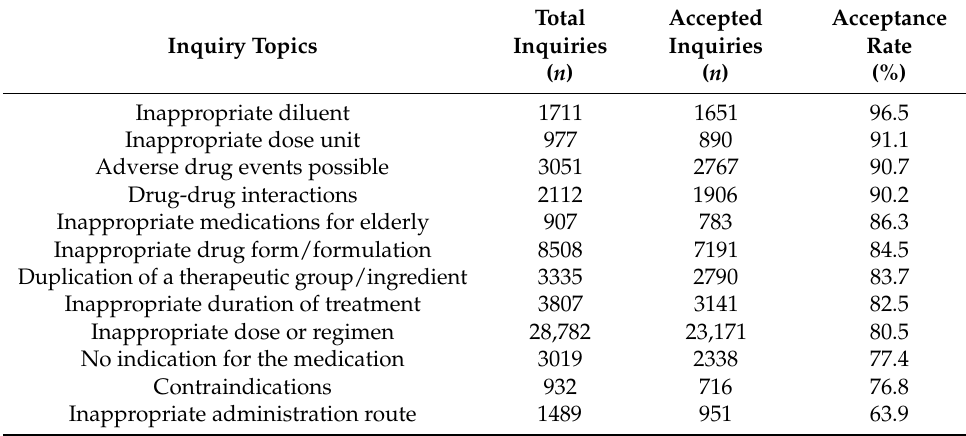
Table 3. Acceptance rates of pharmacists’ recommendations by inquiry